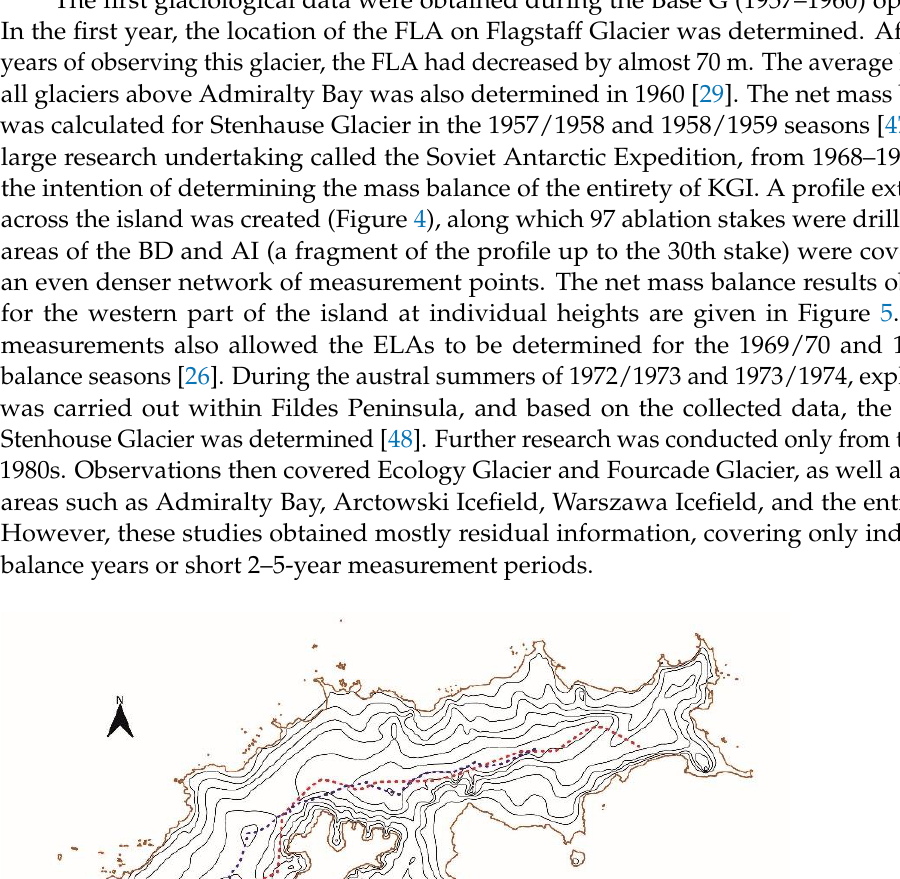
Figure 5. Net mass balances and ELAs on KGI, recorded from 1969 – 1971 mainly on the BD and AI. Reprinted with permission from Orheim and Govorukha [26], published by Cambridge University Press, 1982. One of the best-recognized areas on the KGI in terms of glacial processes is the BD. Ren [50] and, further, Ren at al. [51], designated the ELA of the BD for the 1985/1986 sea- son. Further measurements were made by the Chinese Antarctic Expedition, with the pur- pose of calculating the mass balance and ELA of the dome for the seasons between 1985/1986 and 1991/1992. This work was particularly focused on the last season, in which the study was based on measurements collected at irregular intervals from a network of 64 ablative poles and 15 snow shades between 3 November 1991, and 7 November 1992. The results showed that the mass balance fluctuated slightly compared to those obtained in previous BD studies. In combination with data obtained from 16 ice cores (shallowly drilled at depths of 15.0 – 80.3 m), it was possible to estimate the mass balance over the last 20 years. In addition, a new climatic method was used to estimate mass balance fluctua- tions based on meteorological data obtained from the Frei Meteorological Center station, located just 3 km from the BD. The altitudinal difference between this station and the ELA